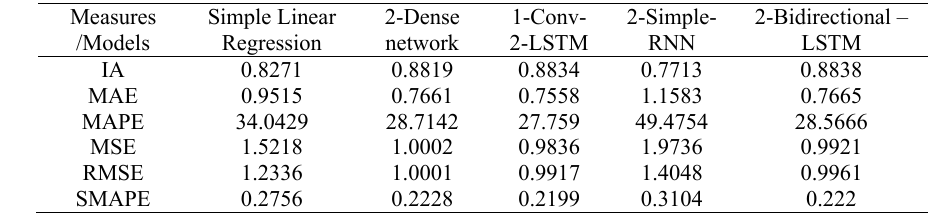
Table 4. Performance evaluation measures for different models on Coimbatore station